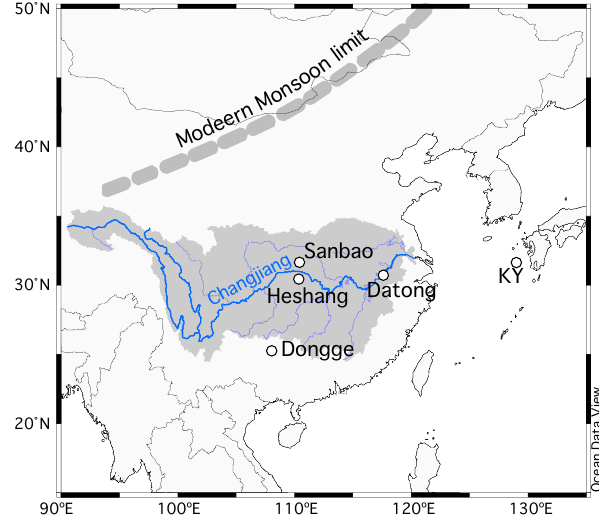
Figure 1. A map showing the Changjiang drainage basin (gray shaded area), Datong hydrological station, cave locations of the speleothem’s study, and the core site of KY07-04-01. A dashed gray line represents the modern northern limit of the monsoon